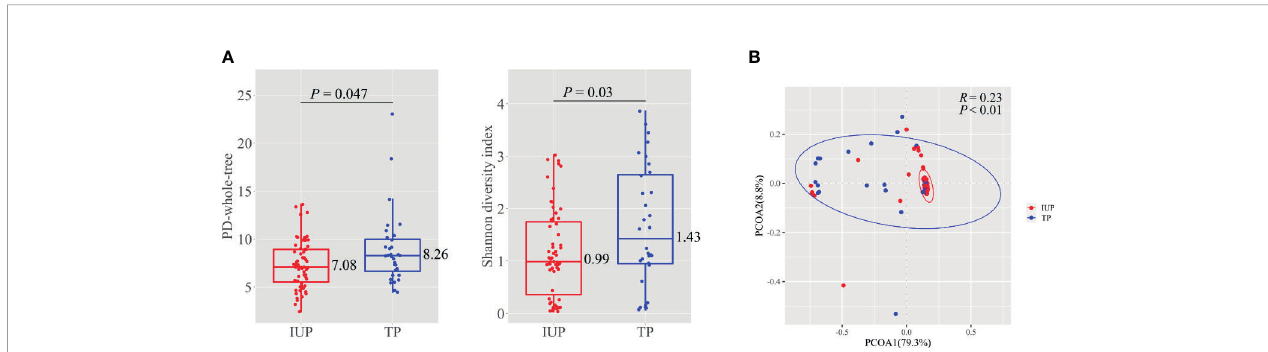
FIGURE 2 | Diversity measures in subjects with intrauterine pregnancy and with tubal pregnancy. (A) Alpha diversity represented by PD-whole-tree and Shannon diversity index in subjects with intrauterine pregnancy and with tubal pregnancy. Boxes with inside line represented interquartile range (IQR) and median, whiskers represented values within 1.5 × IQR of the fi rst and third quartiles, points represented individual subjects. P was calculated by Wilcoxon test. (B) Principal coordinate analysis (PCoA) based on weighted UniFrac distances between the subjects with intrauterine pregnancy and with tubal pregnancy. Points represented individual subjects, and ellipses represented 95% con fi dence intervals around the cluster centroid. ANOSIM calculated R and P to determine the signi fi cance of clustering. Red indicated intrauterine pregnancy and blue indicated tubal